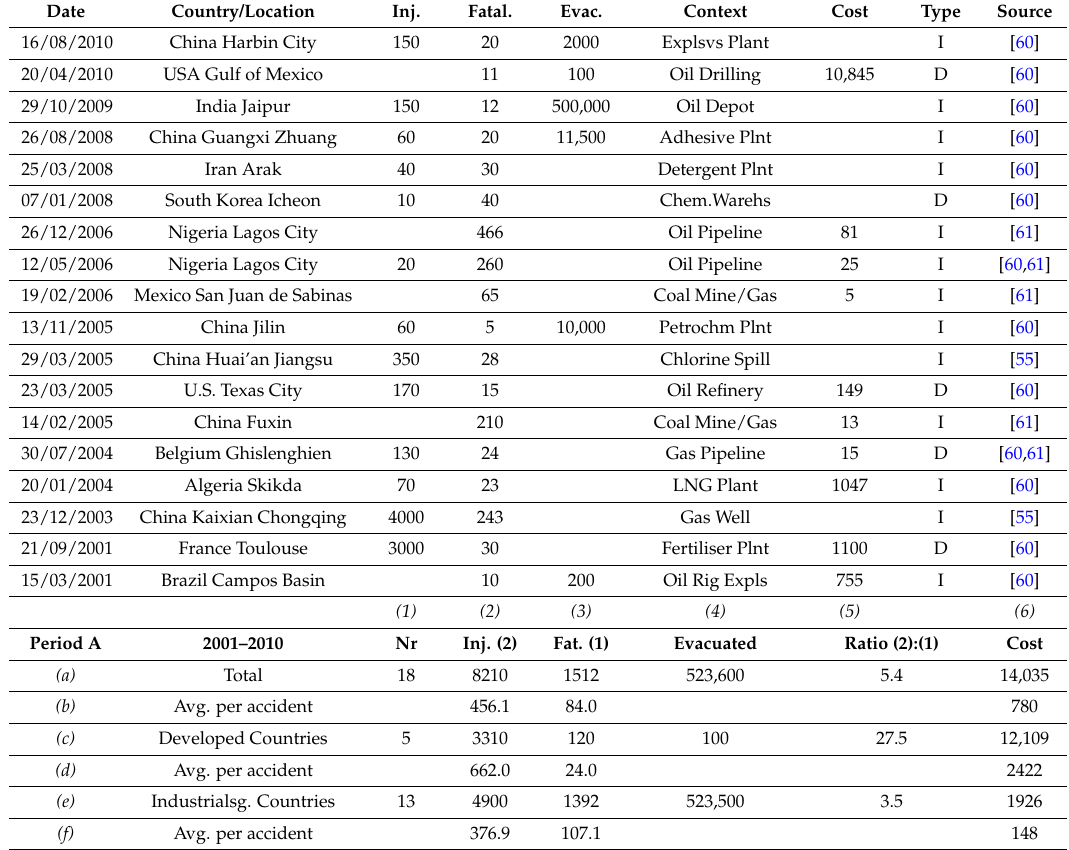
Table 1. Period A,